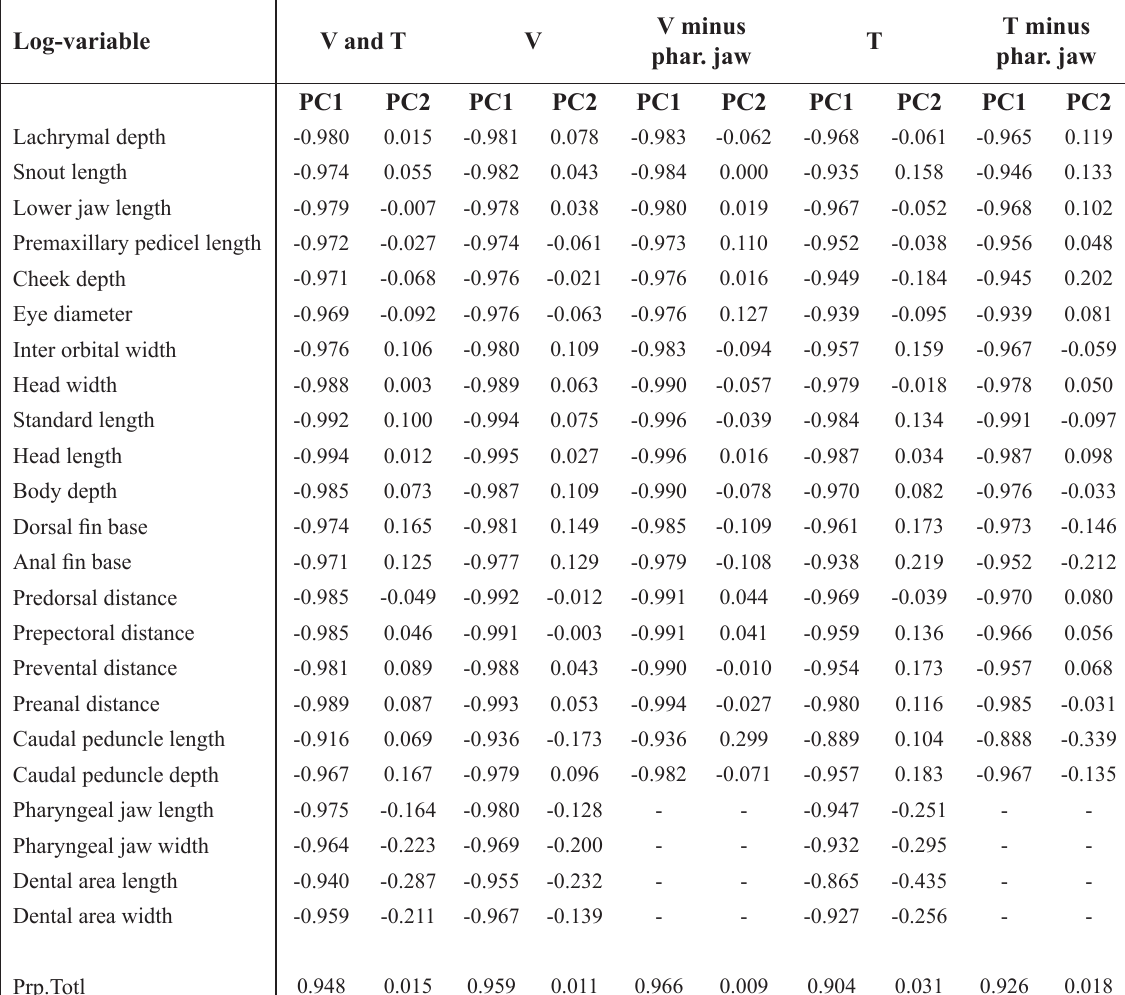
Table 2. Principal component loadings of the first two axes of the log-transformed morphometrics for five PCAs performed on the Astatoreochromis specimens examined: PCA on Victoria (V) and Tanganyika (T) systems, PCA within the Lake Victoria system including (V) and excluding (V minus LPJ) the lower pharyngeal jaw measurements, and similarly for the Lake Tanganyika system (respectively T and T minus